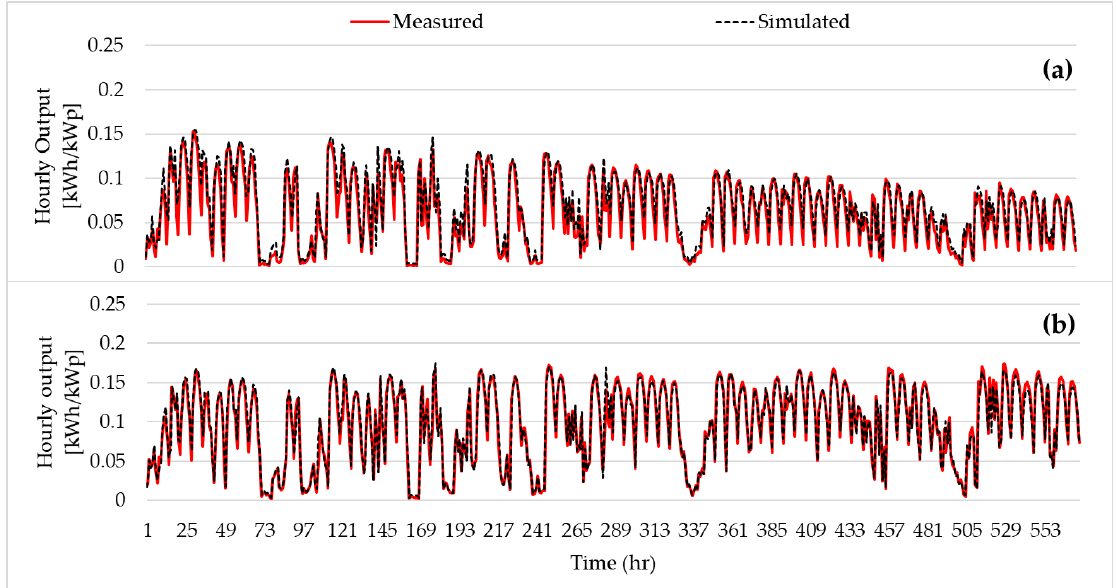
Figure 11. Comparison of hourly PV outputs between reference measured and simulated data: ( a ) vertical and ( b ) inclined plane positions.